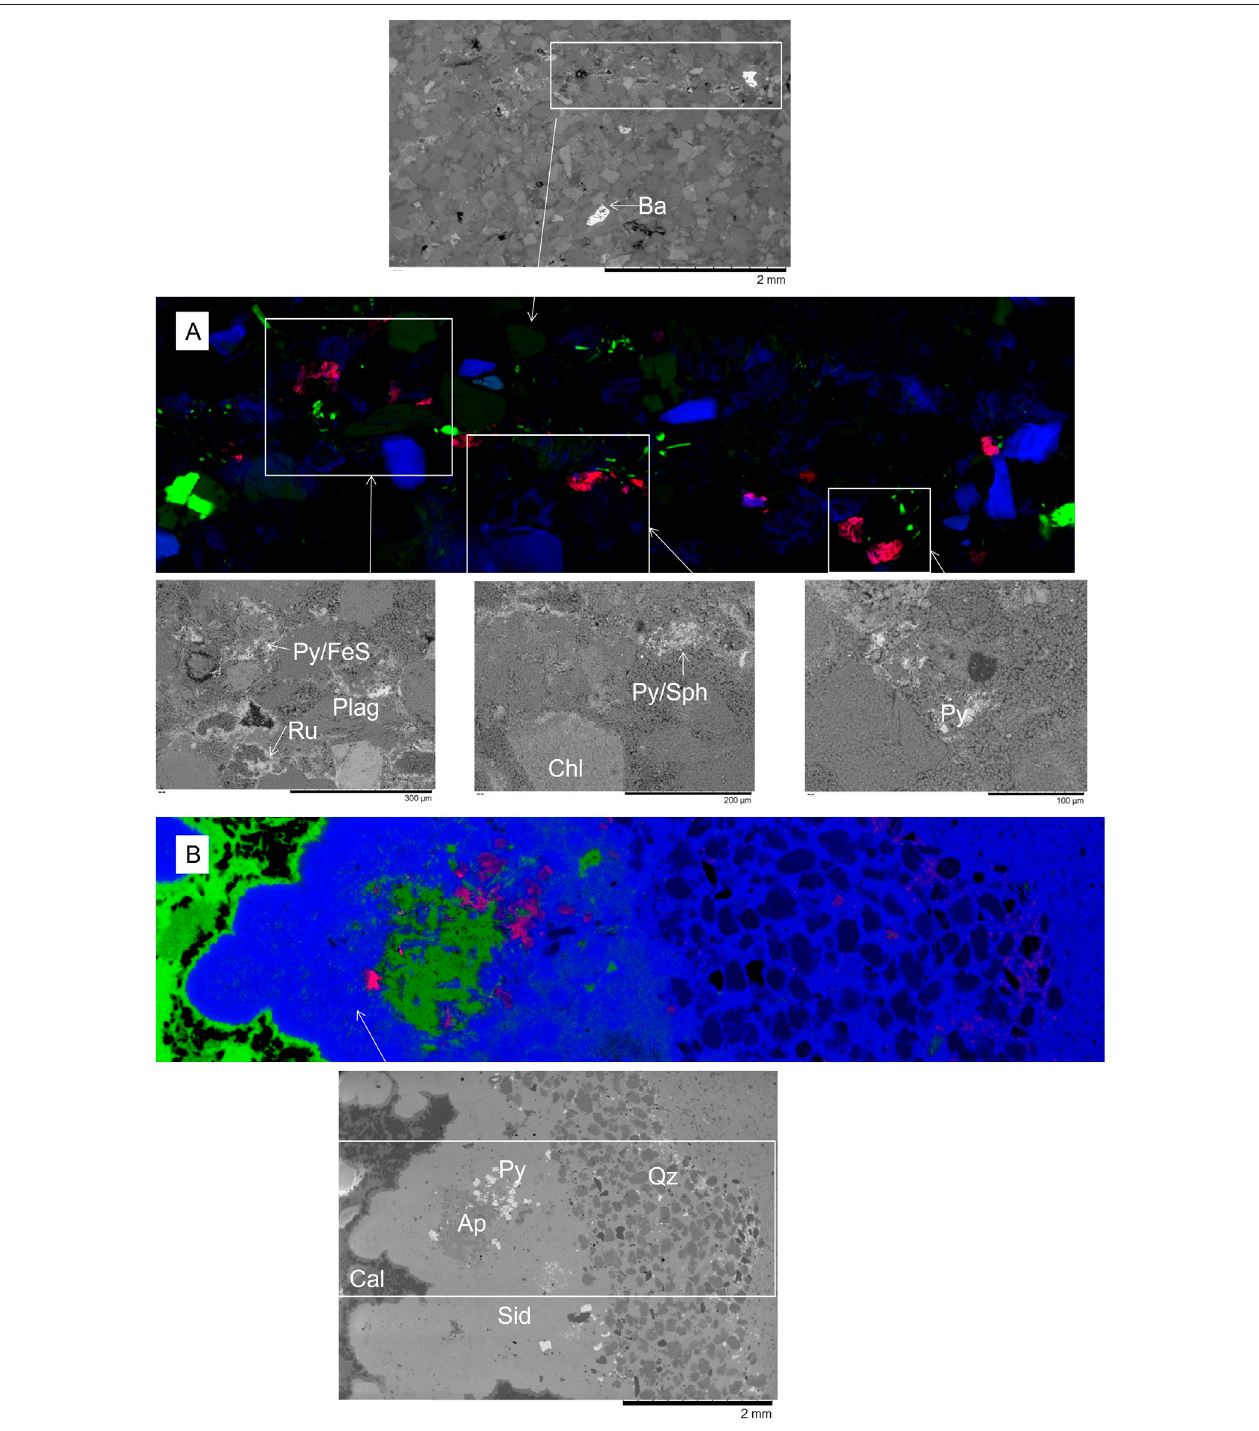
FIGURE3|(A) XFMimageoffeldspar-rich sandstone from1043.70 mwhere red=As,green=Ca,and blue=Fe.Maximum concentration shown ofAs=0.97%, Ca =30.4%,and Fe=33.8% intheimage. (B) XFMimageofironstone from 1022.40 m whereAs=0.96%,Ca =94.4%,and Fe=75.1%in theimage. AssociatedSEM imagesofareasareshown ofthewhiteboxed areas,with Ba,barite cement;Py, pyritecement;Sph, sphalerite cement;Ru, rutile cement; Chl,chlorite;Pla,plagioclase; Cal, calcite; Sid, siderite; Ap, apatite cement; Qz, quartz grains.